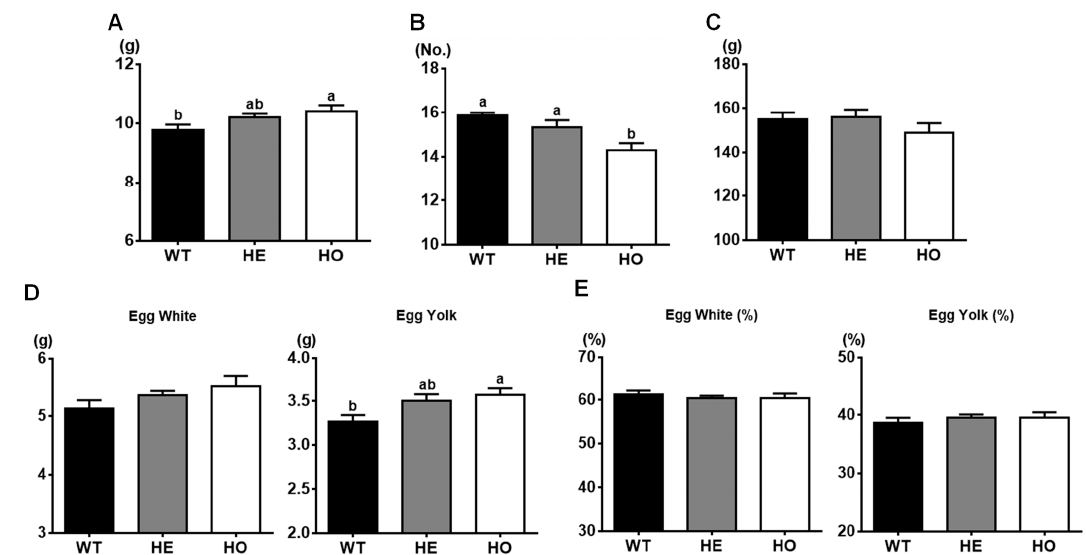
Figure 2. Comparisons of egg quality and quantity traits of WT, HE, and HO female quail from 90 to 110 days of age. ( A ) Egg weights. ( B ) Egg numbers. ( C ) Total egg production. ( D ) Weights of egg whites and yolks. ( E ) Percentage proportions of egg whites and yolks in egg weights. Values present means ± SEM. n = 9 WT females, 9 HE females, and 10 HO females. One-way ANOVA was used for statistical analysis by the GraphPad PRISM. a–b Means that have no superscript in common in a graph are different ( p < 0.05). No.: Number of eggs.